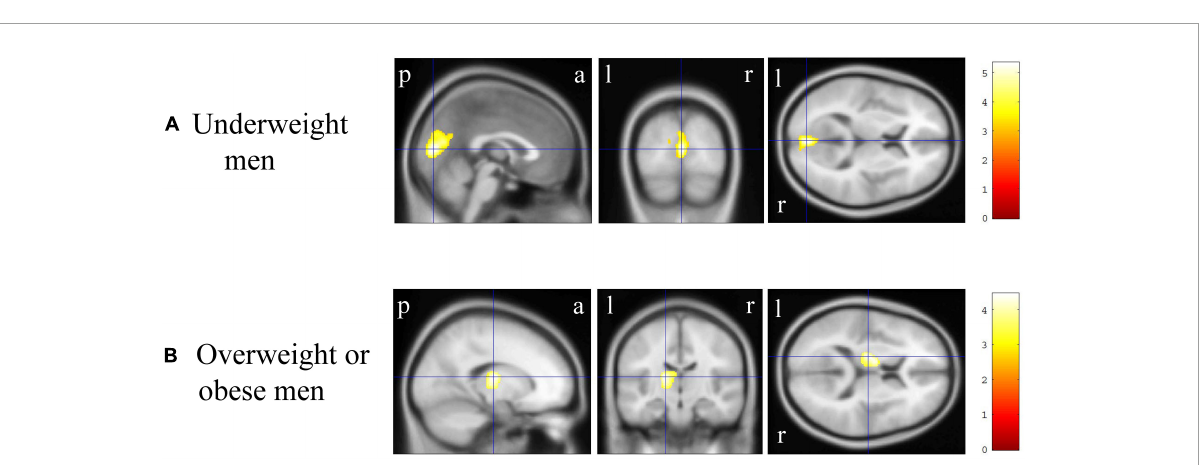
FIGURE3 Gray matter regions where the volume was associated with underweight and overweight or obese men. (A) Gray matter volume in the bilateral cuneus and calcarine cortex, left cuneus and calcarine cortex, and bilateral cuneus was reduced in underweight men when compared with that in non-underweight men [ p < 0.01 corrected, Montreal Neurological Institute (MNI) 152 T1 atlas coordinates: x = 0.0 mm, y = − 84.0 mm, z = 9.0 mm indicated by blue cross-hair lines]. (B) Gray matter volume in the left cerebellum exterior was reduced in overweight or obese men when compared with that in underweight or normal men ( p < 0.05 corrected, MNI 152 T1 atlas coordinates: x = − 16.5 mm, y = − 16.5 mm, z = 12.0 mm indicated by blue cross-hair lines). Right-sided gradient color bars represent t -scores. a, anterior; l, left; p, posterior; r, right.